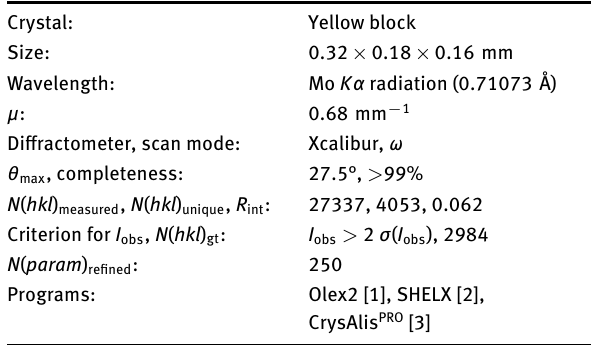
Table 1: Data collection and